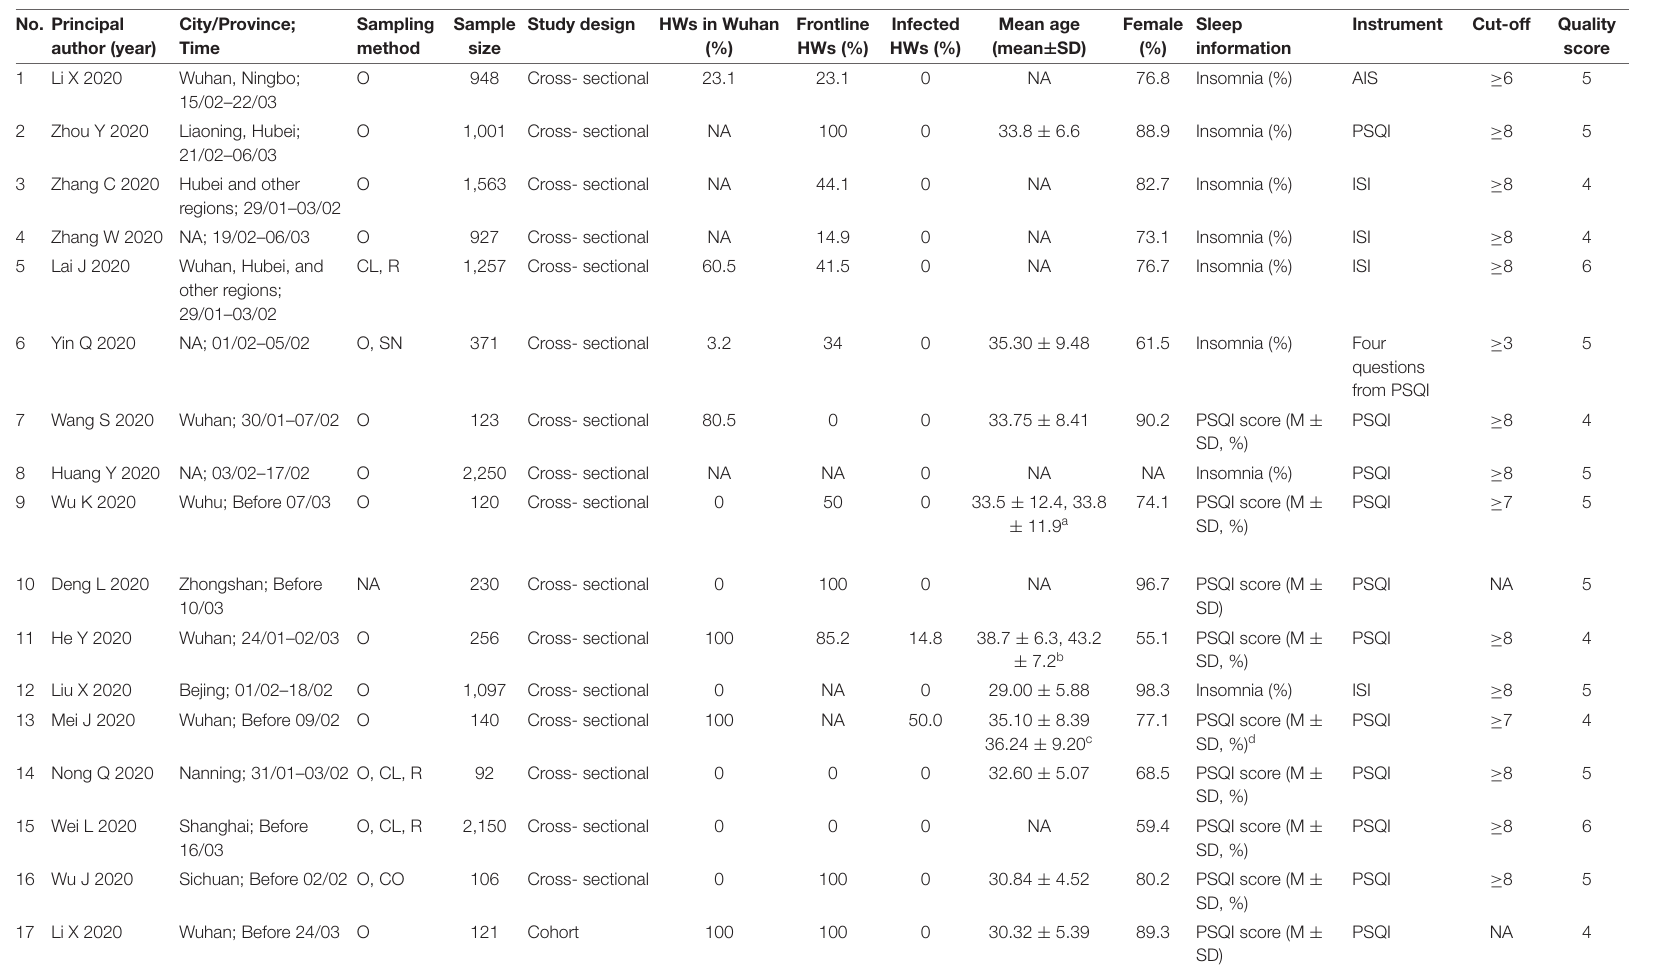
TABLE 1 | Characteristics of the studies included in the